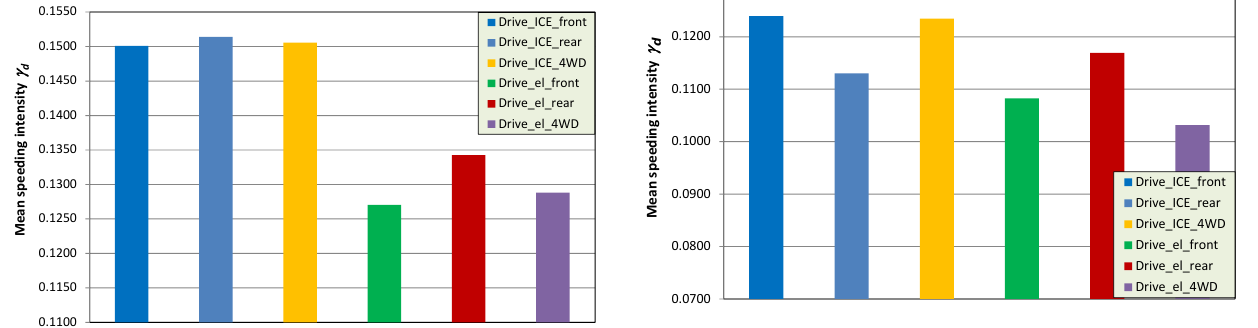
Fig. 6. Mean speeding intensity in speeding the vehicle straight ahead on a road with homogeneous high adhesion coefficient [own research]